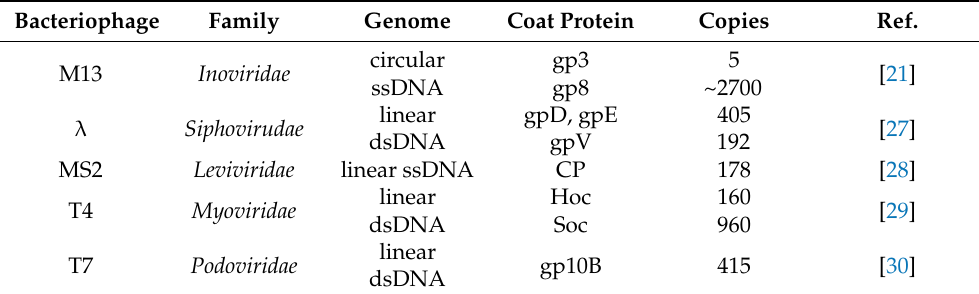
Table 1. Platforms for phage